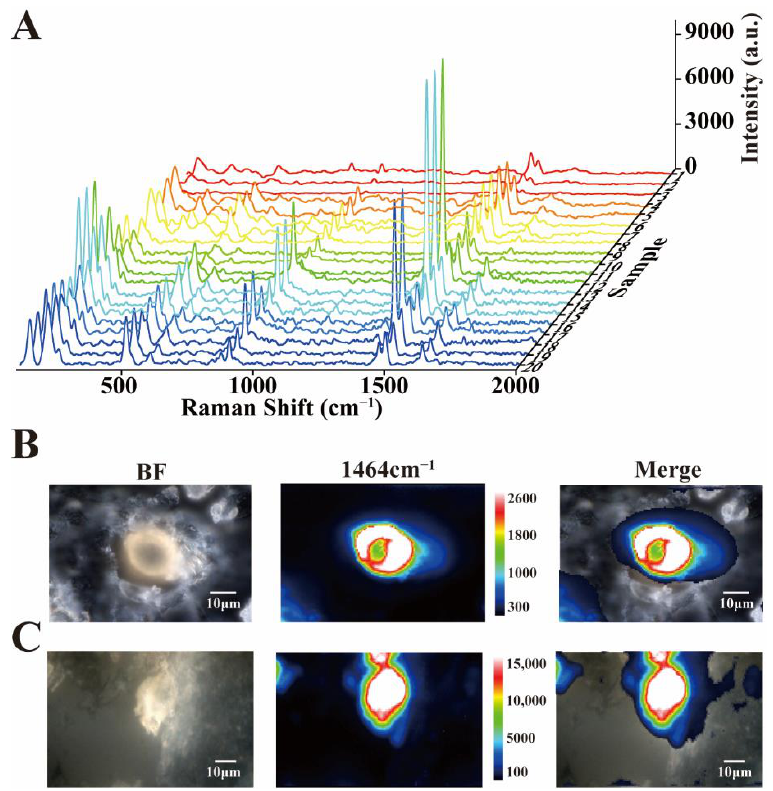
Figure 3. ( A ) Raman spectra of 20 random crystals in tissue sections from the patient. ( B ) Raman mapping of calcium oxalate dihydrate crystals (magnification 1000×). ( C ) Raman mapping of mapping of calcium oxalate dihydrate crystals (magnification 1000 × ). ( C ) Raman mapping of calcium calcium oxalate dihydrate crystals (magnification 600×). BF = bright field. oxalate dihydrate crystals (magnification 600 × ). BF = bright